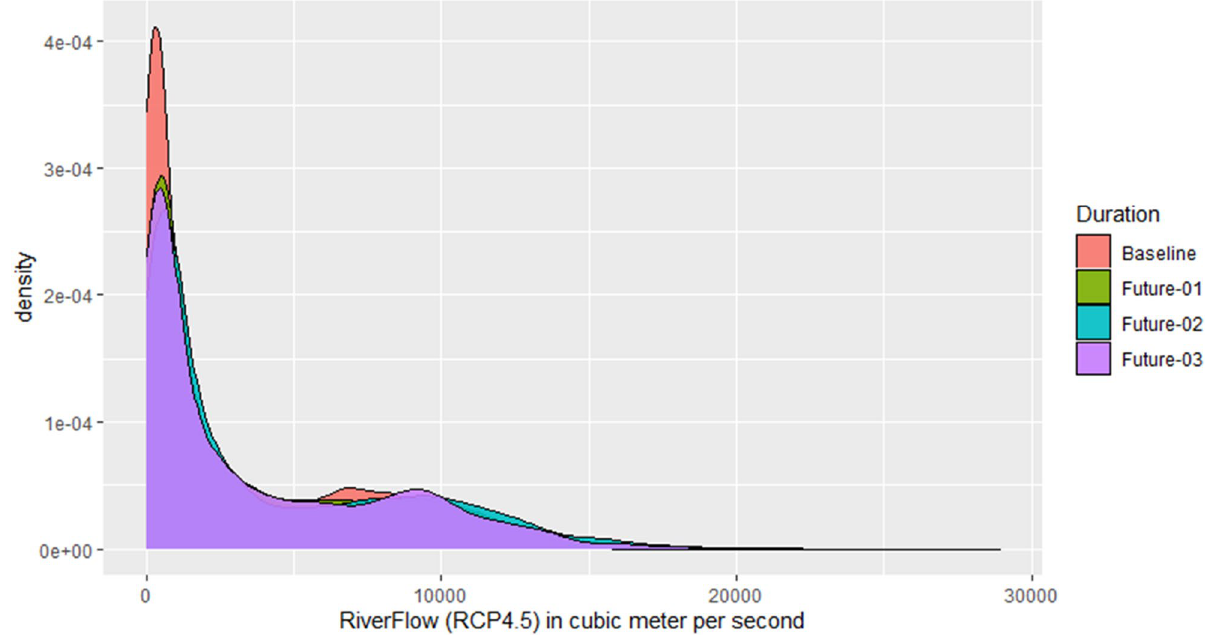
Figure 8. Comparison of probability distribution of the futures’ river flow with the baseline (1976–2005) for RCP4.5. River flow is mentioned on x-axis in cubic meter per second while their density is mentioned on y-axis. The future durations are: Future-01 = 2011–2040, Future-02 = 2041–2070, Future-03 = 2071–2100.